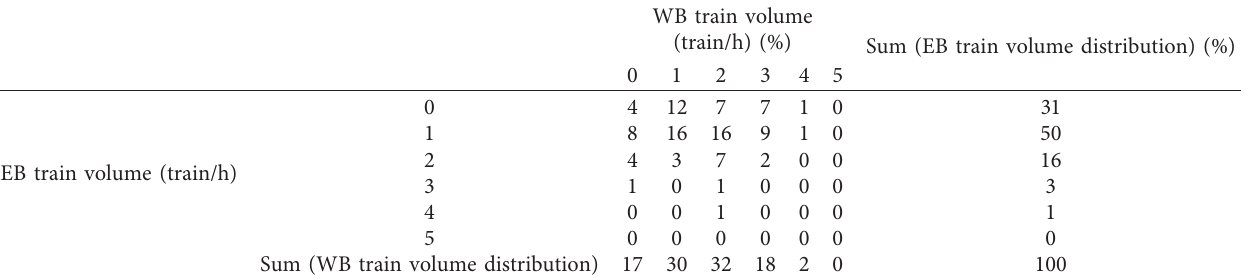
Table 1: Train volume distributions.